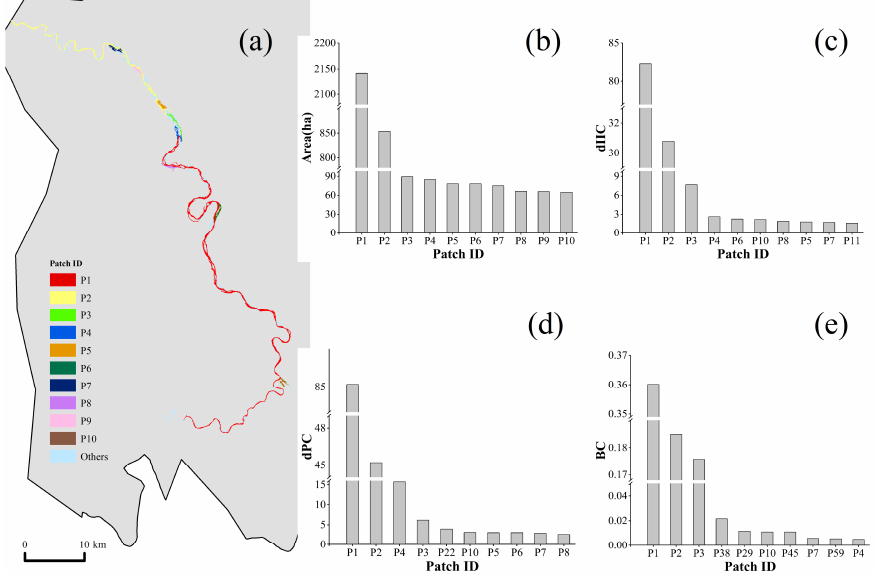
Figure A4. Statistics of different indices for the top 10 patches obtained from the results of connectivity modelling for 2010. ( a ) Distribution of patches, ( b ) Area of patches (n), ( c ) dIIC, ( d ) dPC, and ( e ) BC.